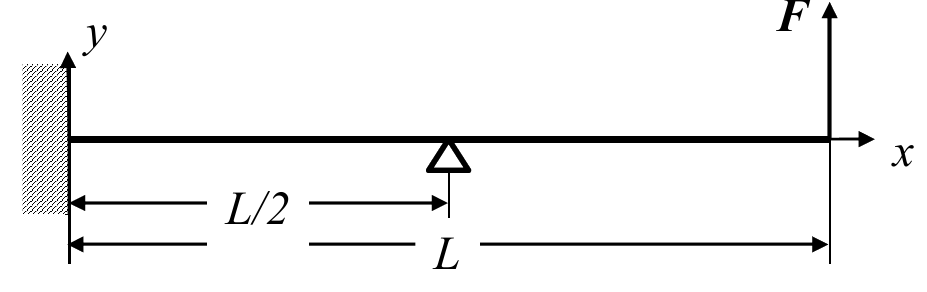
Figure 6. Cantilever beam model with a tip force.